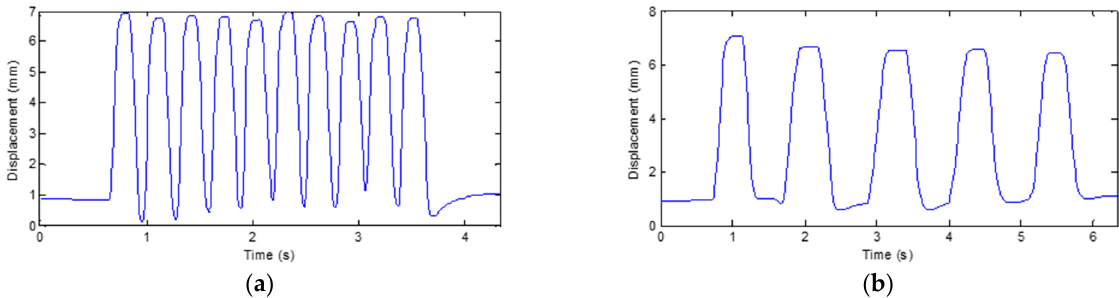
Figure 13. Results of Test A in response testing on human finger. ( a ) Fast flexion and extension; ( b ) Slow flexion and extension.